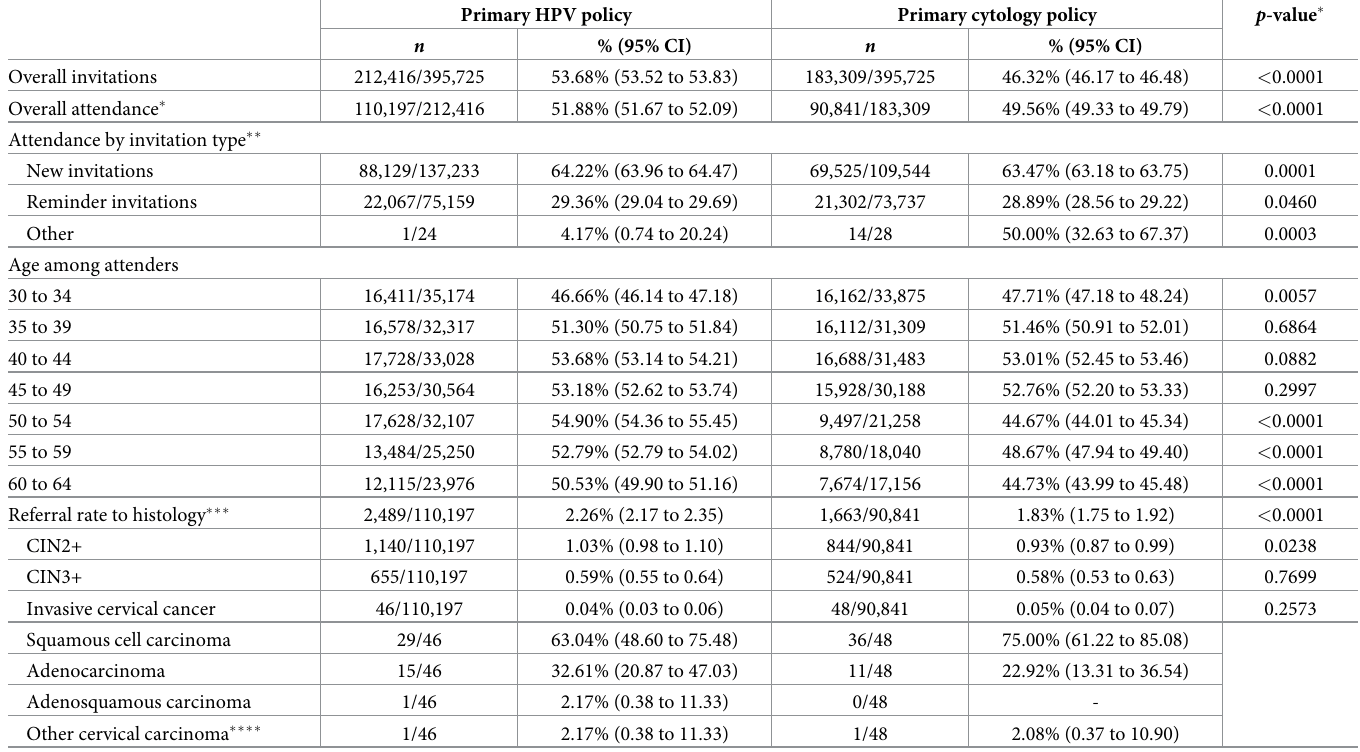
Table 1. Overall invitations, attendance, and referral to histology by study arm (PP